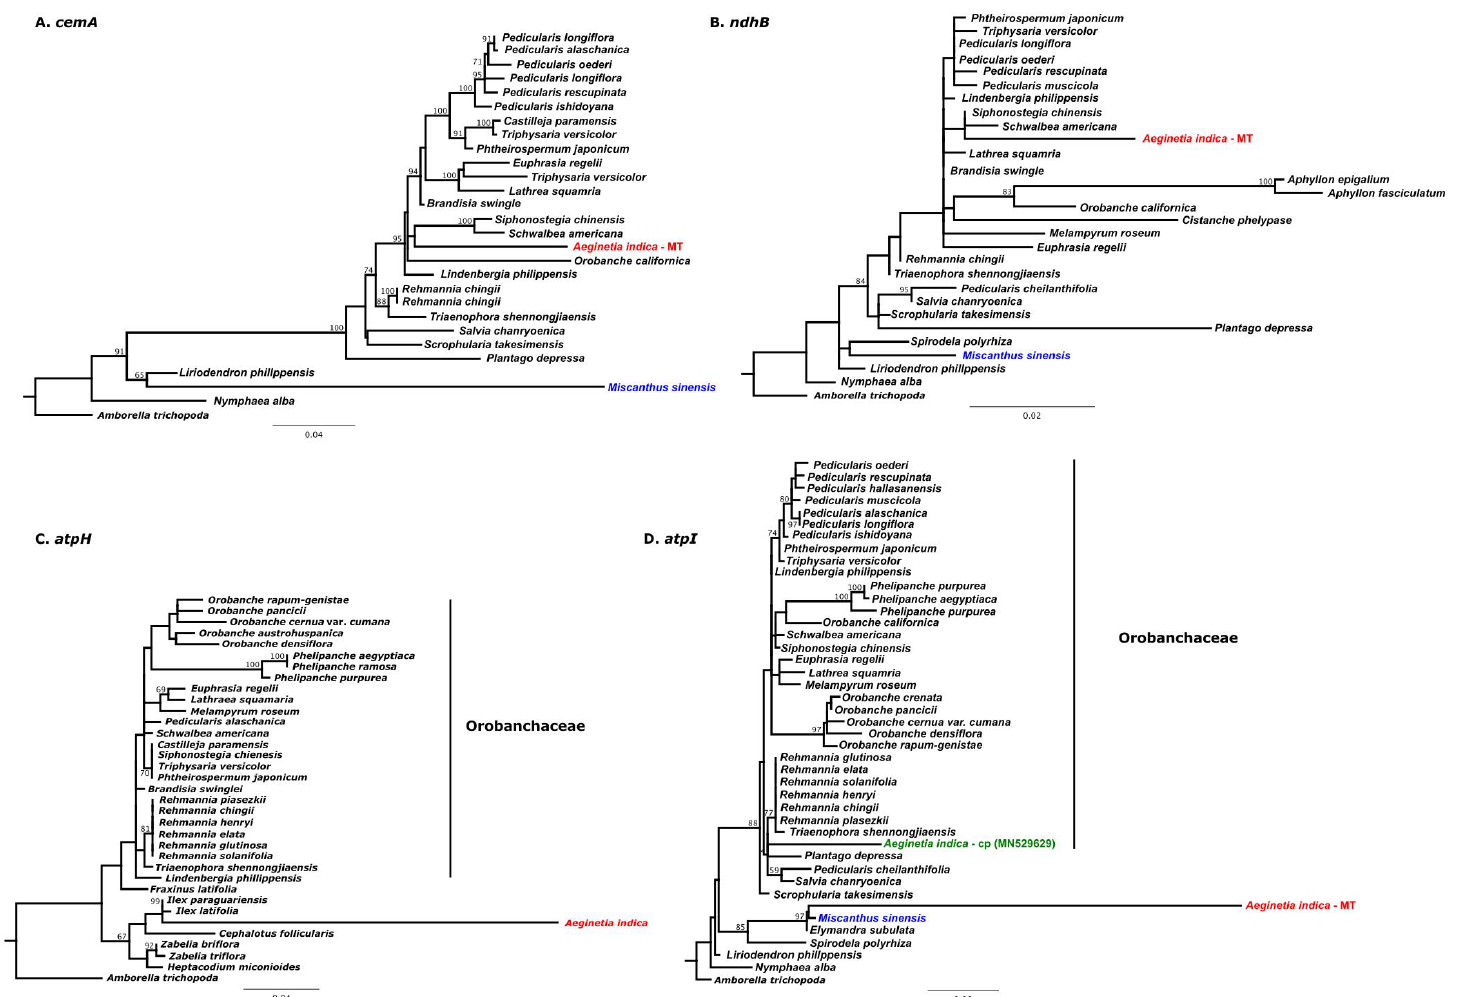
Figure 3. Phylogenetic evidence for intercellular gene transfer (IGT) and horizontal gene transfer (HGT). Maximum-likelihood trees based on chloroplast genes ( A – D ). Bootstrap values of > 60% are shown on branches. ( A ) IGT of fragment of the cemA gene in the A. indica mitogenome ( B ) IGT of fragments of the ndhB gene in the A. indica mitogenome ( C ) HGT of atpH in the A. indica plastid genome ( D ) HGT of atpI in the A. indica mitochondrial genome. Colors indicate A. indica (red) and Miscanthus sinensis (blue).